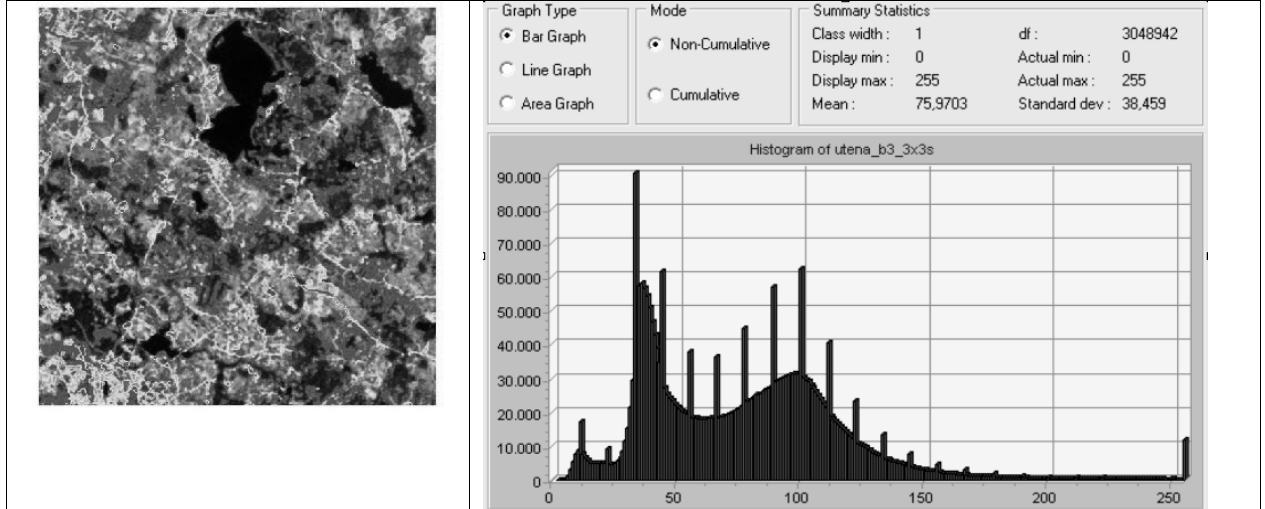
Fig 4 . Three band picture of LANDSAT 5 and scattering